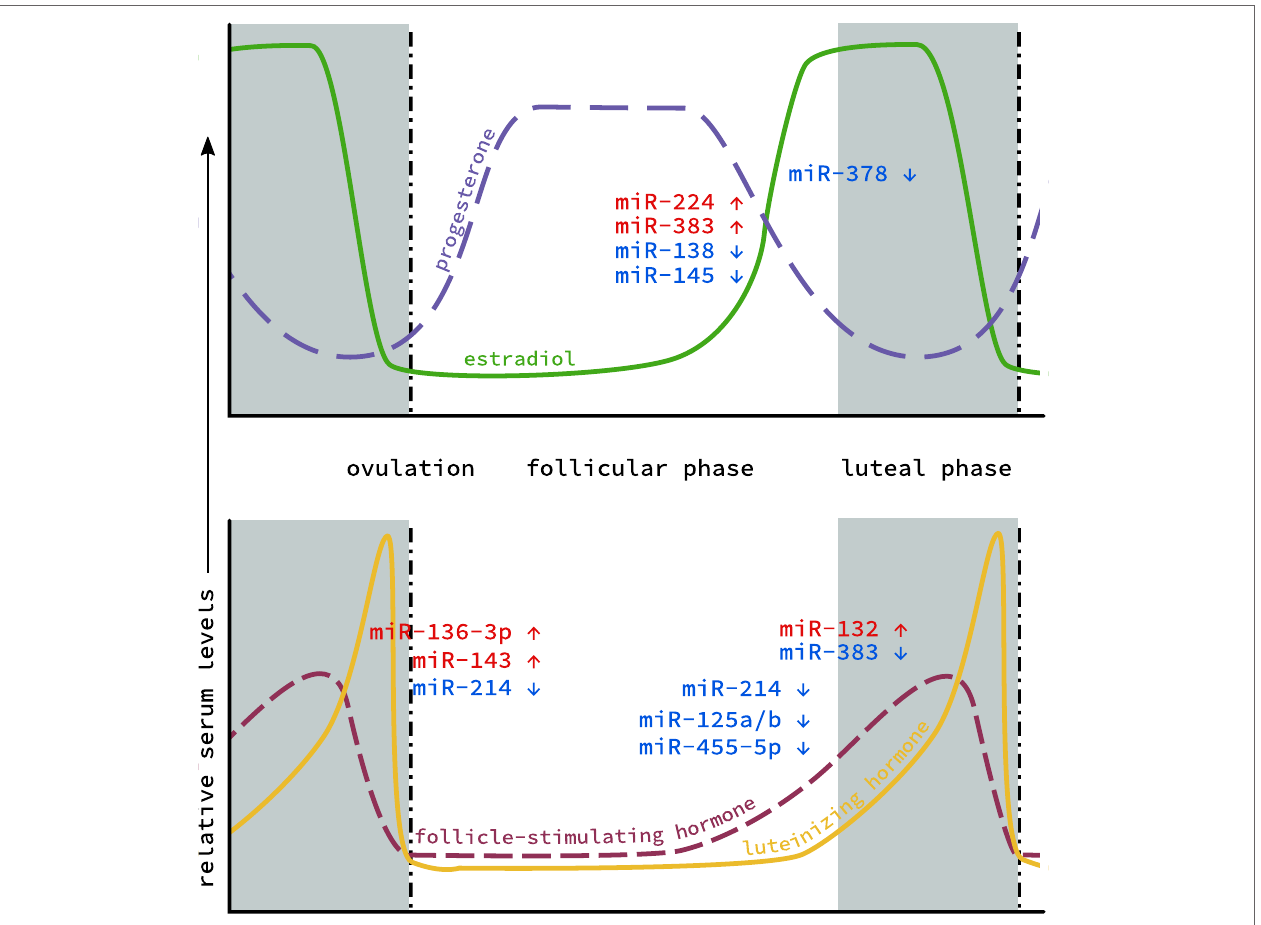
FiGURe 1 | MicroRNA (miRNA) levels in the ovary during the estrous cycle. Levels of the two main classes of endocrine hormones, steroid (top) and gonadotropin (bottom), fluctuate throughout the course of the cycle. Similarly, miRNA expression has also been shown to fluctuate between the follicular phase (gray), through ovulation (dotted line) to the luteal phase (white). Individual miRNAs are depicted based on whether their expression increases (red) or decreases (blue) during this